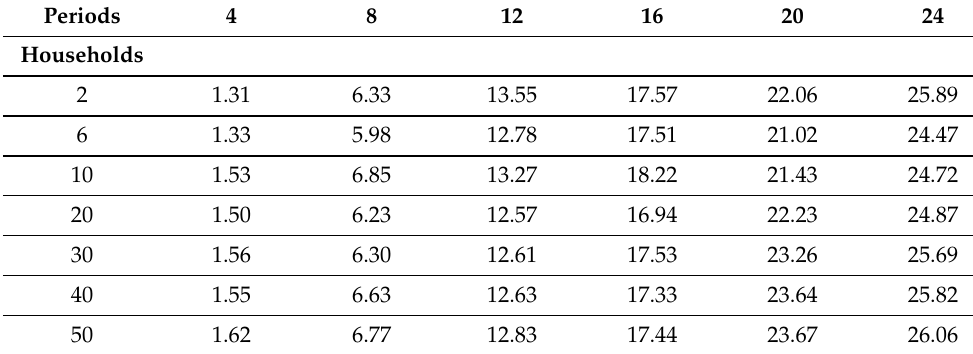
Table 5. Median cost UPR values for algorithm IA with Cuboid Homothets Stage